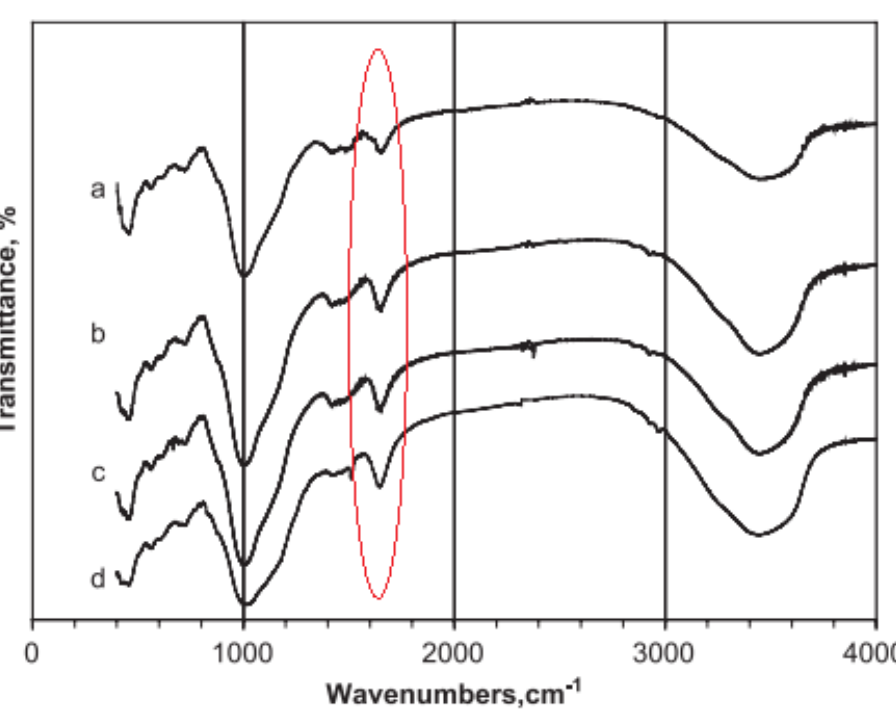
Figure 15. Variation in the vibration of molecular water due to a sulfate attack (a) control, (b) 5% sodium sulfate exposure, (c) 5% magnesium sulfate exposure, and (d) combination (From Elsevier Ref. [86] and used with permission). Table 1. Some of the significant bands in the FTIR spectra of cementitious materials.